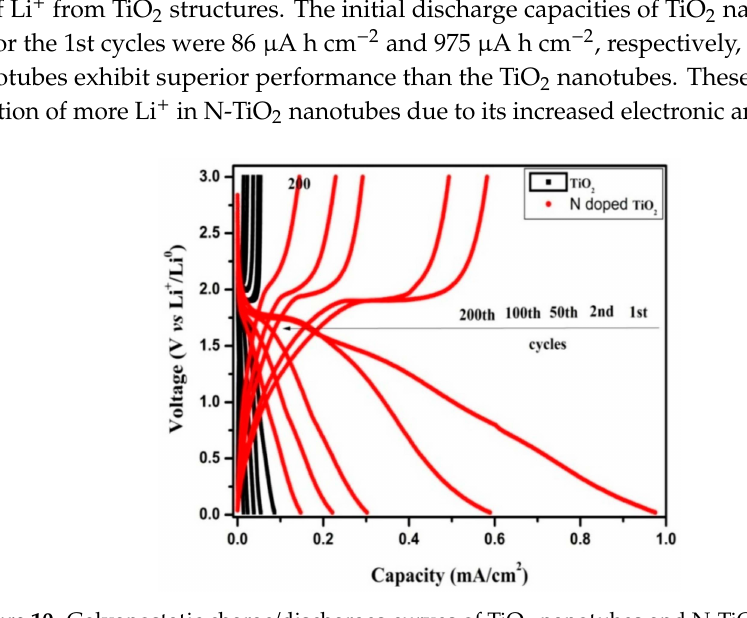
Figure 10. Galvanostatic charge / discharges curves of TiO 2 nanotubes and N-TiO 2